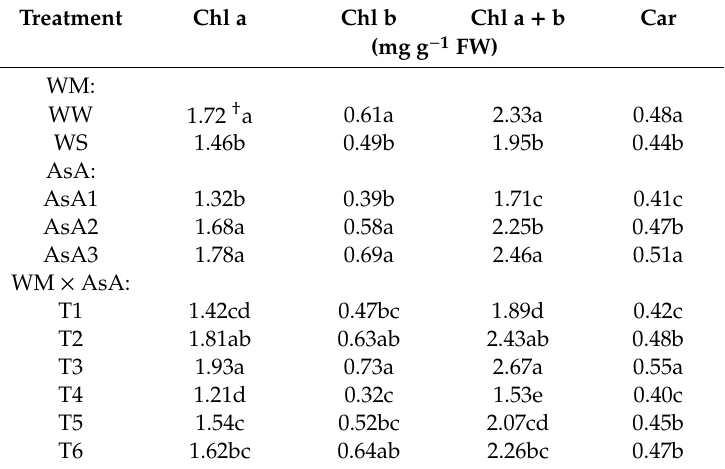
Table 1. The e ff ect of water management (WM) and ascorbic acid (AsA) on photosynthesis pigments of chlorophyll a (Chl a), chlorophyll b (Chl b), chlorophyll a + b (Chl a + b), and carotenoids (Car) of common bean